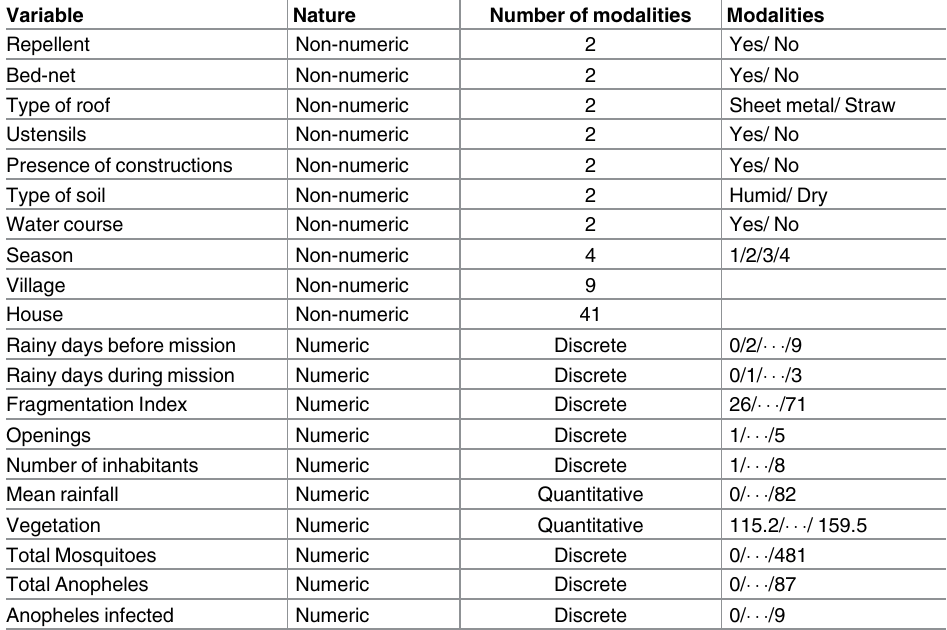
Table 1. Description of original variables.